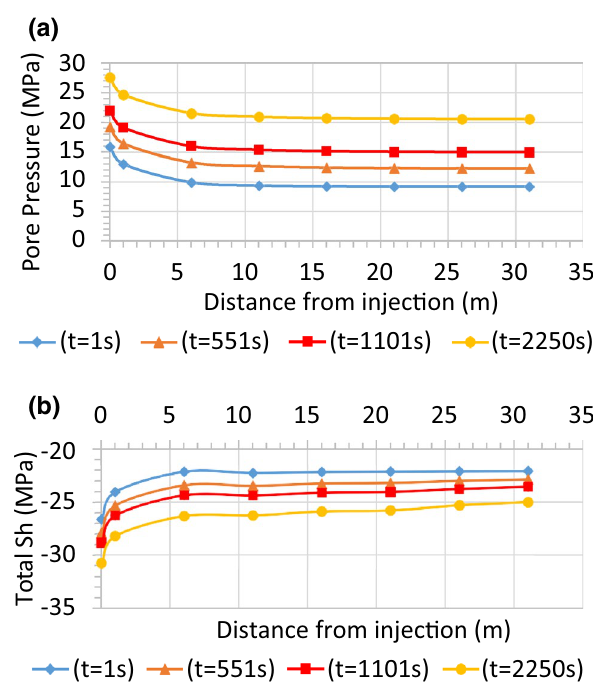
Fig. 9 Case 1 ( k = 23.4 mD): a Pore pressure versus distance and b total minimum horizontal stress versus distance along SRV length from the injection port at various injection times